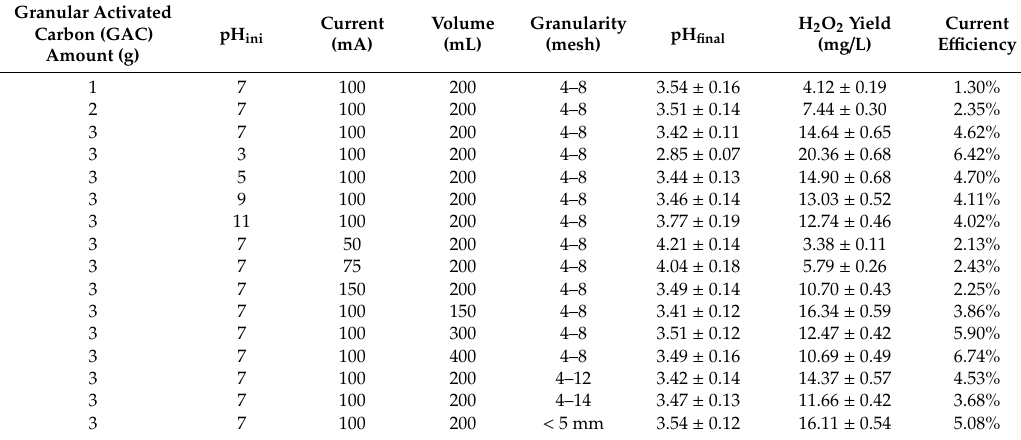
Table 1. Yields of hydrogen peroxide and determined current e ffi ciencies after reaction for 60 min under various